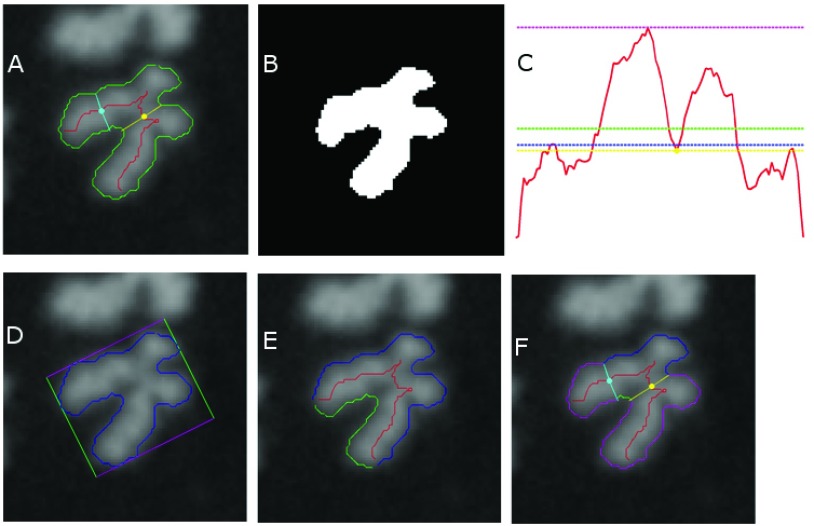
A visualization of DC filter scores for a particular false positive (FP).
DC filters are defined in Methods. (
A) A processed FP (chromosome with SCS), with contour in green, centerline in red, top-ranked centromere candidate and its width traceline in yellow, 2
nd-ranked centromere candidate and its width traceline in cyan. (
B) Filter i: Thresholded binary image of the chromosome is used to calculate pixel area (in white). (
C) Filters ii–v: Width profile along centerline is shown in red (horizontal axis plots centerline location, vertical axis plots width), with mean width in green (filter ii), median width in blue (filter iii), max width in magenta (filter iv), and width of top centromere candidate in yellow (filter v). (
D) Filter vi: Contour in blue and its minimum bounding rectangle in magenta and green. (
E) Filter vii: Partitioning of contour at centerline endpoints (intersection of red line with contour) into two segments, green and blue. (
F) Filter VIII: Traceline endpoints of top 2 centromere candidates (intersection of yellow and cyan lines with contour) are used to partition contour into 4 segments (1 blue, 1 green, 2 magenta); relative arc lengths of blue and green segments are taken into consideration.